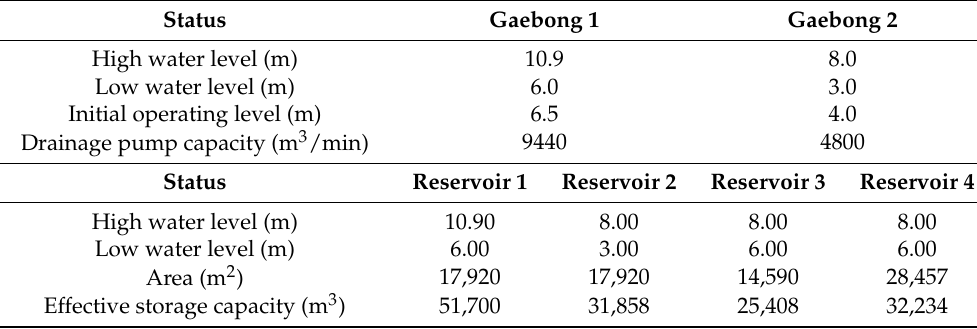
Table 3. Information of the drainage facilities in the target watershed.